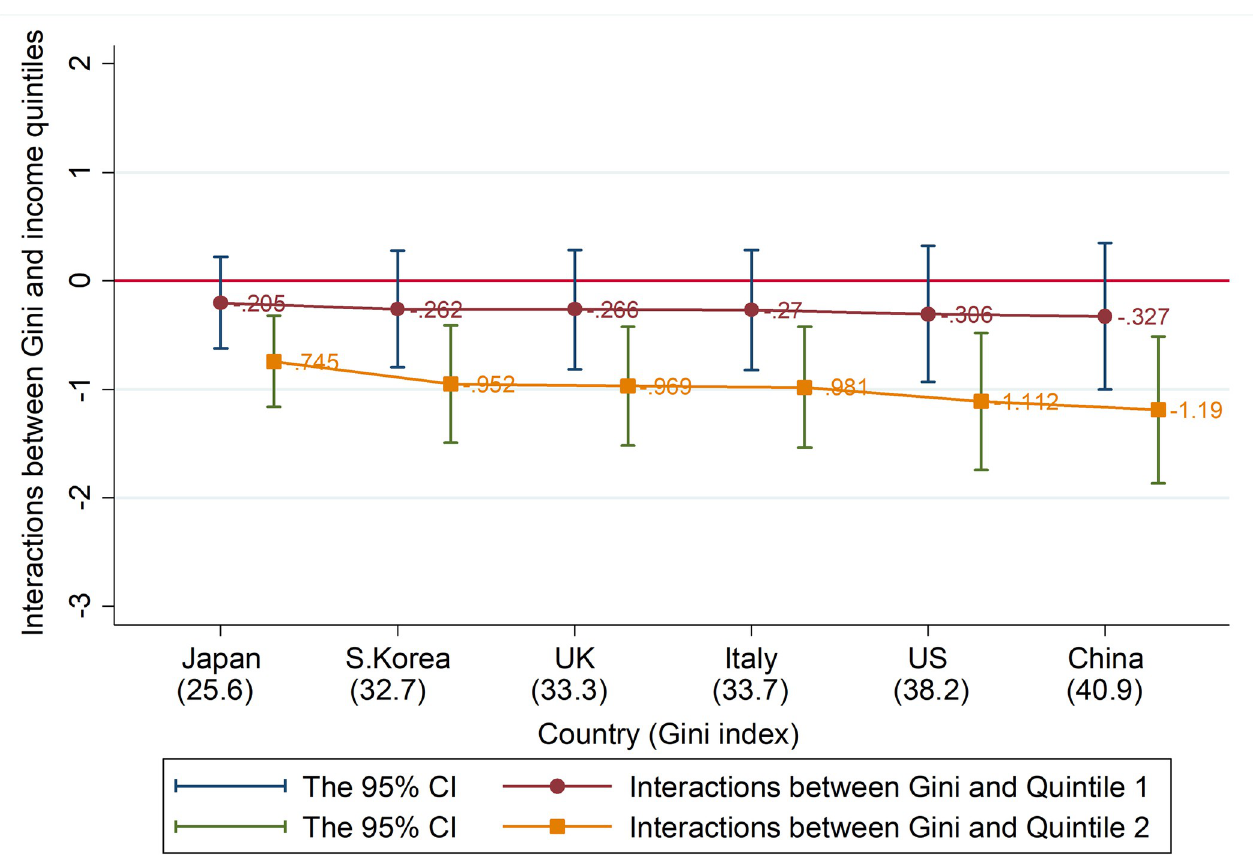
Fig 3. Estimated interactions between Gini index and income quintile. This figure presents the estimates of the interactions between Gini index and income quintiles in regressions of ‘Believe in the approach of the government in response to the pandemic’. The Gini index of each country is reported in parentheses. The full regression results using the pooled sample are reported in Table A.7 in Appendix A of S1 File.